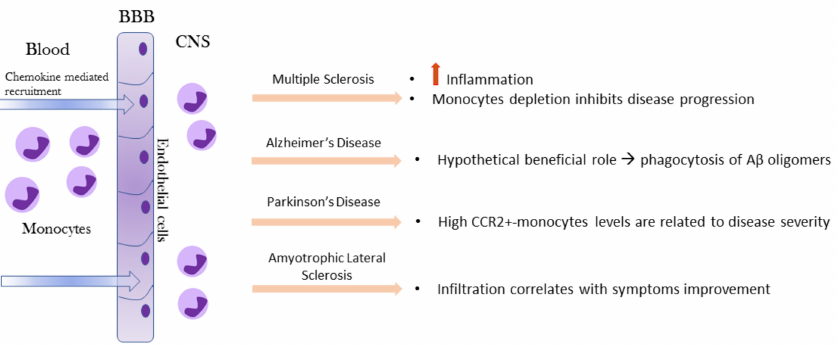
Figure 3. Recruitment of circulating monocytes into the brain and their impact on MS, AD, PD, and ALS. Monocytes enter the brain due to BBB disruption and in response to chemokines gra- dients. In the CNS compartment, monocytes assume a different role based on the specific neu- rodegenerative microenvironment signals. BBB, blood–brain barrier; CNS, central nervous system; MS, multiple sclerosis; AD, Alzheimer’s disease; PD, Parkinson’s disease; ALS, amyotrophic lat- eral